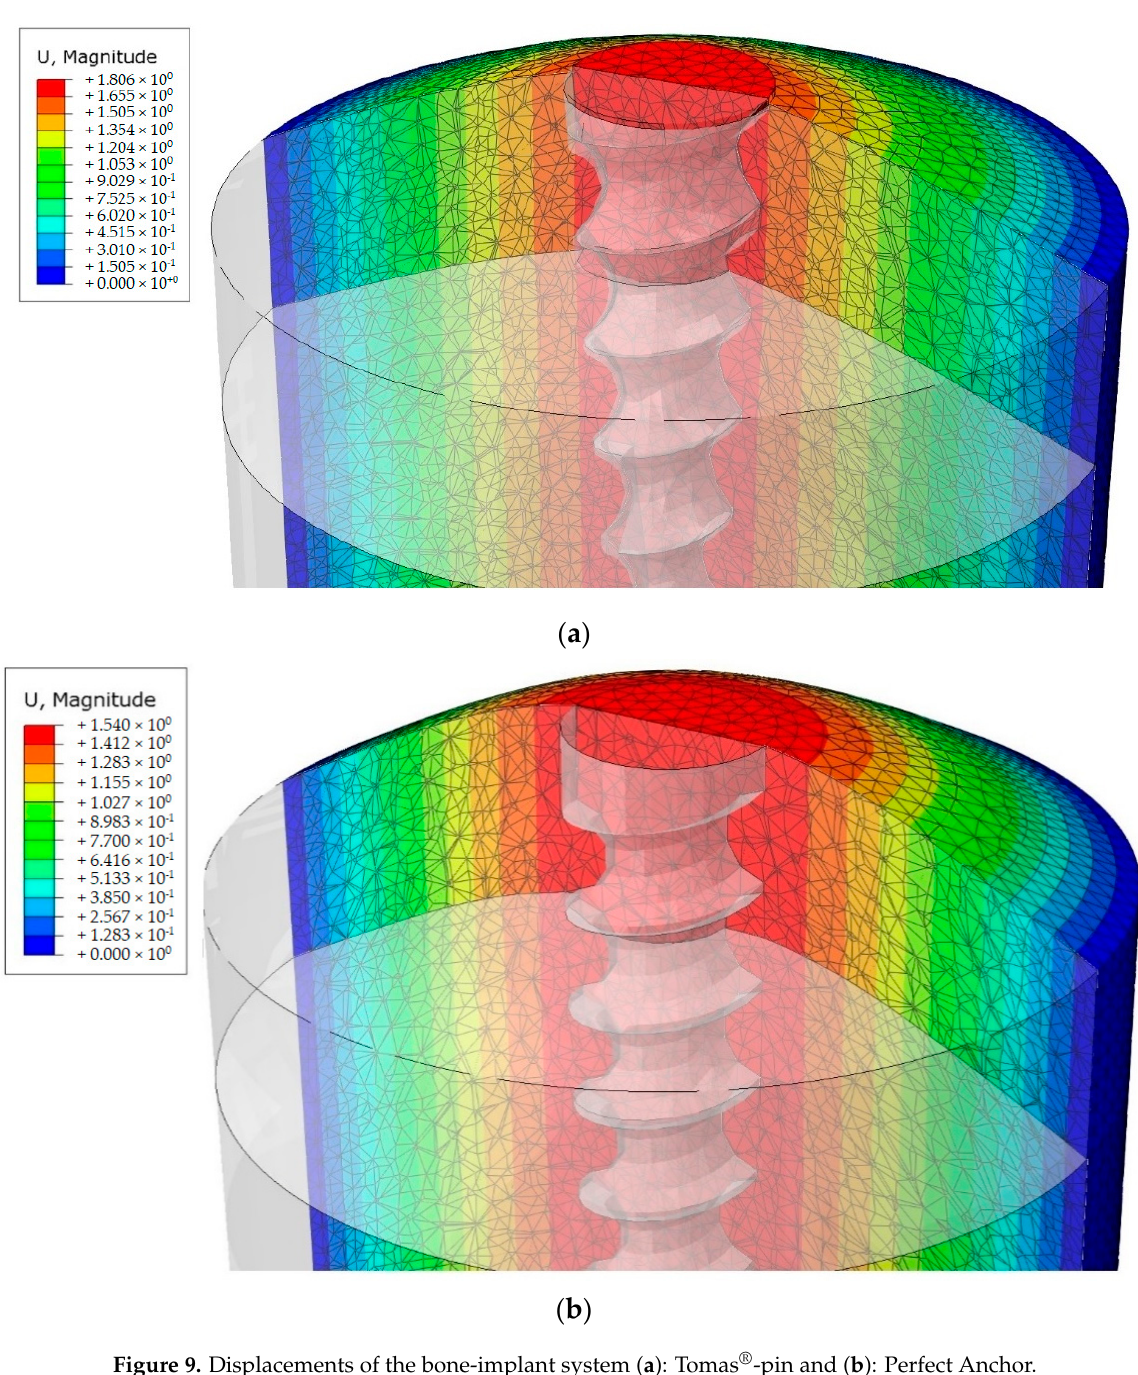
Figure 9. Displacements of the bone-implant system ( a ): Tomas ® -pin and ( b ): Perfect Anchor.